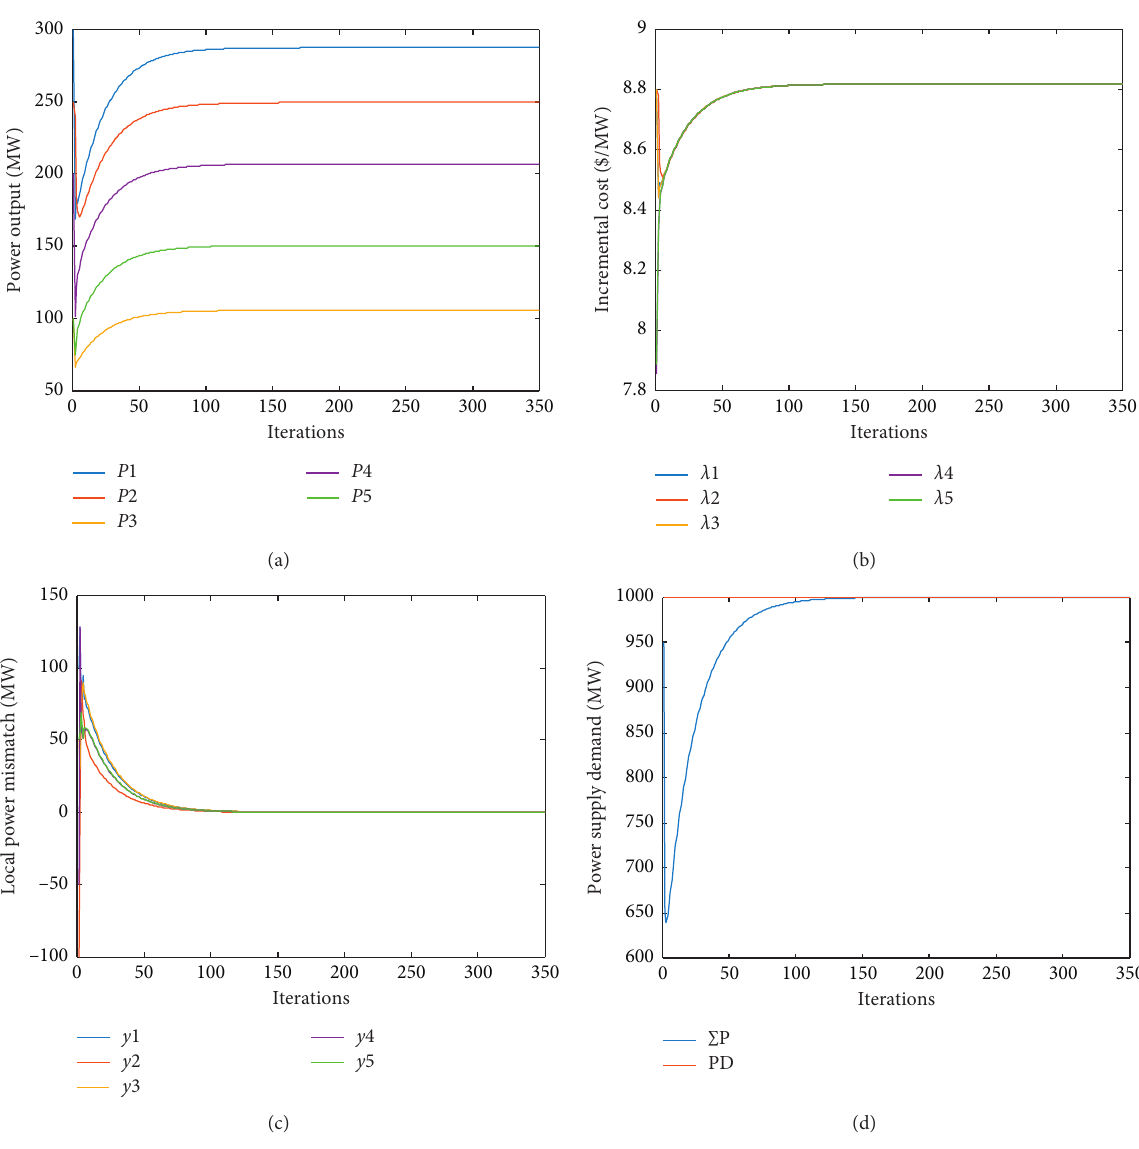
Figure 3: The convergence results of the dispatch system under ideal communication conditions. (a) The power output of each generator. (b) The incremental cost of each generator. (c) Auxiliary variable y of each generator. (d) Total power output and load